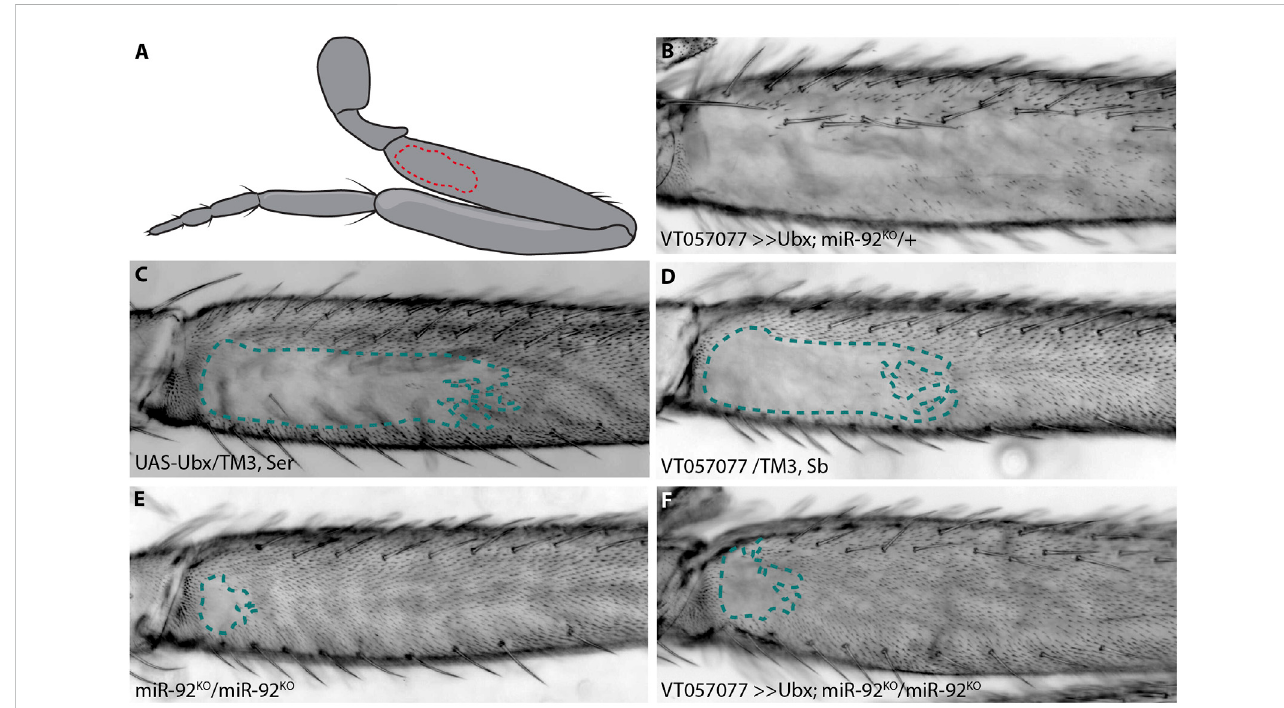
FIGURE 1 Ubx requires miR-92 genes to repress trichomes. The naked valley is a region of trichome-free cuticle on the posterior side of the proximal femur (outlined by dotted lines) (A) . Over-expression of Ubx inhibitstrichome formation on most of theT2 femur (B) while the UAS-Ubx line (C) and the GAL4 driver line VT057077 (D) both have large naked valleys. Naked cuticle is almost absent in miR-92 loss of function T2 legs (E) . Trichome inhibition by Ubx over- expression is restricted to the most proximal region of the femur in miR-92 KO (F)